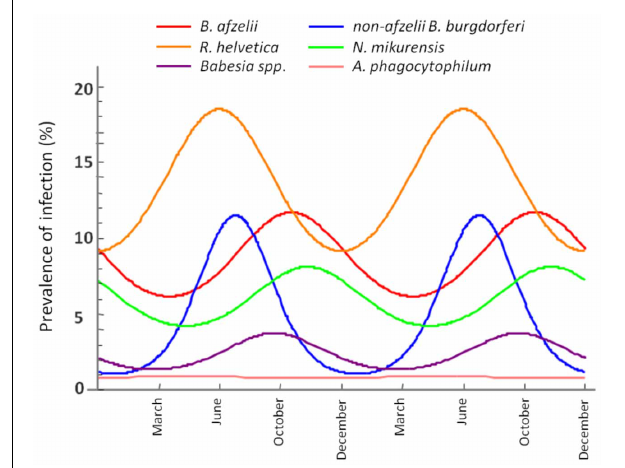
FIGURE 6 | Seasonal variation of the infection rate in ticks. The maximum infection rates of non- afzelii B. burgdorferi , and R. helvetica are in June, while the maximums of B. afzelii, N. mikurensis , and Babesia spp. overlap in October.